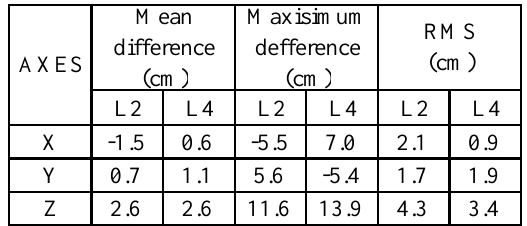
Table 3. Results of Absolute Accuracy Assessment